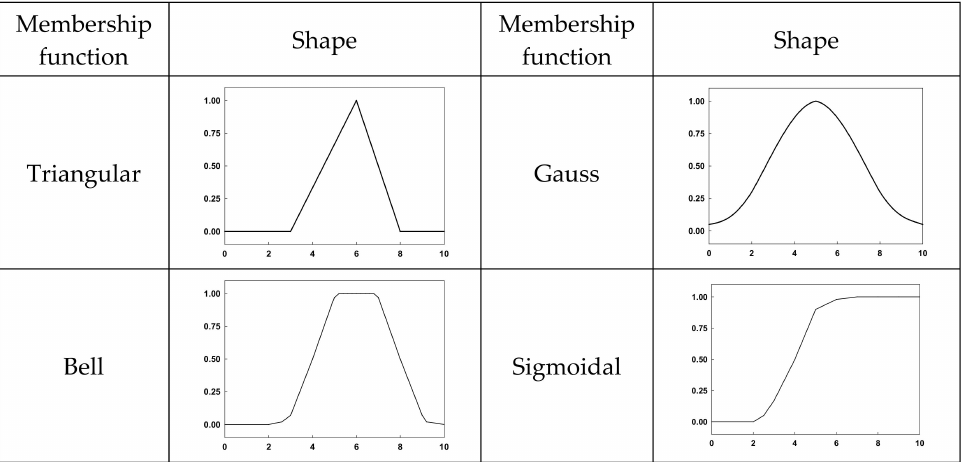
Figure 7. Shapes of fuzzy membership functions for input